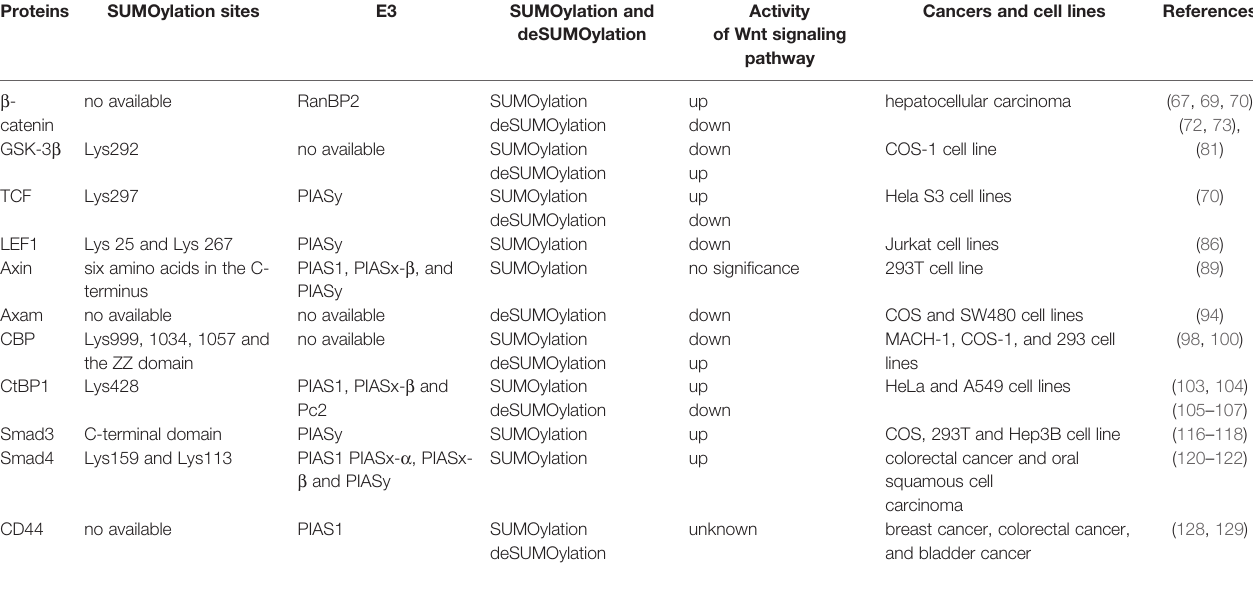
TABLE 1 | SUMOylation on the key proteins involved in Wnt/ b -catenin signaling pathway and their corresponding effects on the activity of Wnt/ b -catenin signaling pathway. Proteins SUMOylation sites E3 SUMOylation and